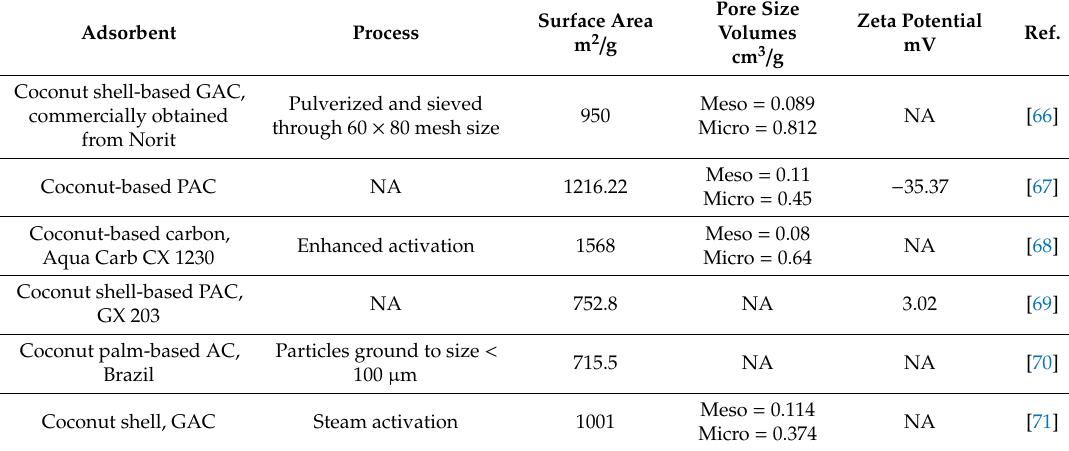
Table 3. Characteristics of coconut-based activated carbon